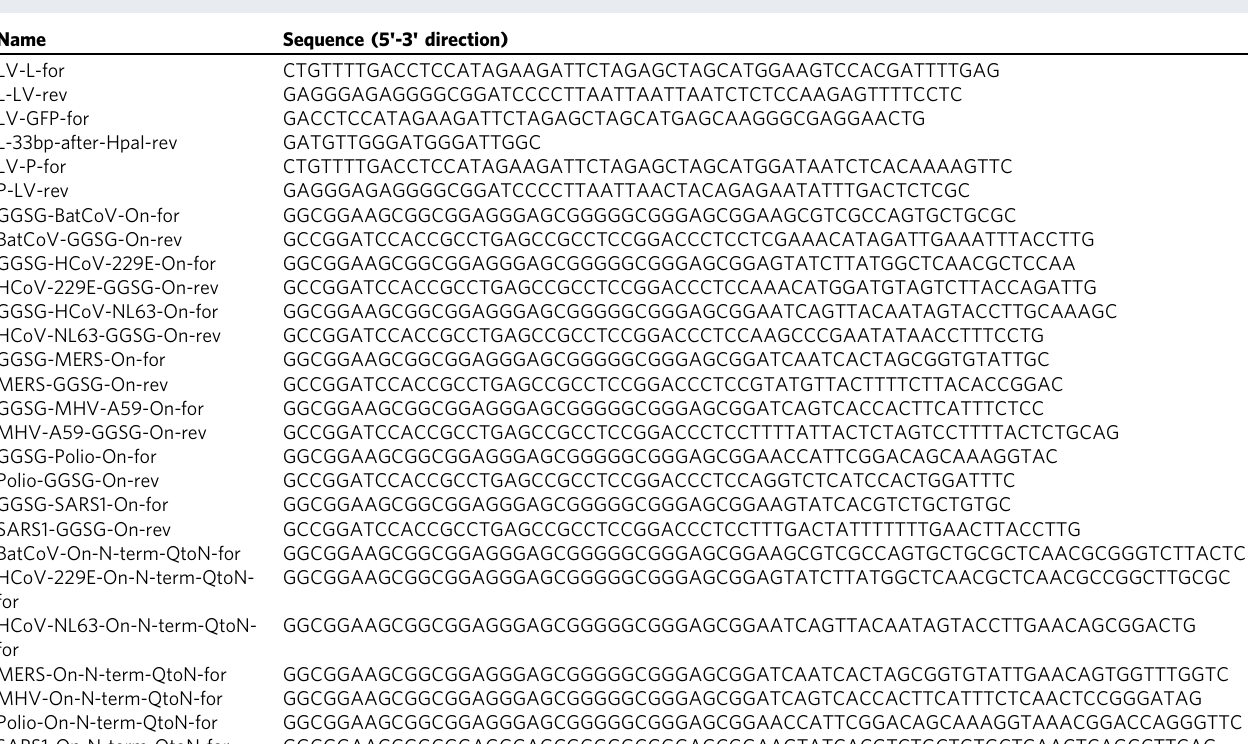
Table 2 cloning primer for lentivirus plasmids.